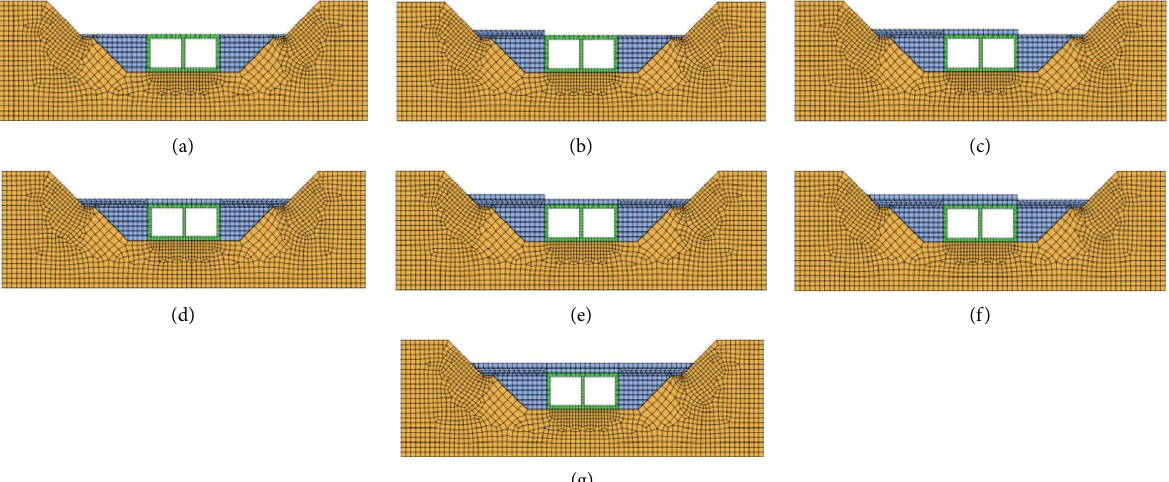
Figure 10: Backflling from left-to-right: Case